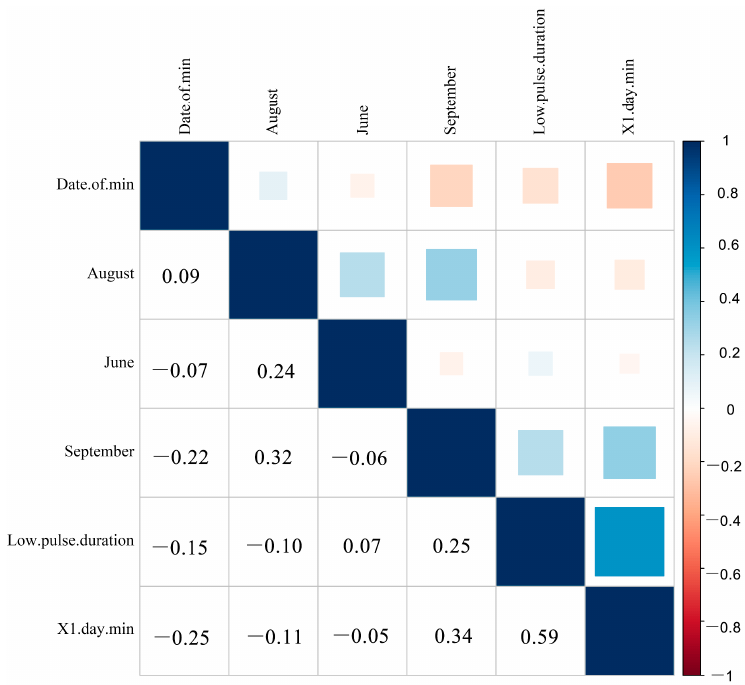
Figure 7. Thermal diagram of the ERHIs correlation.